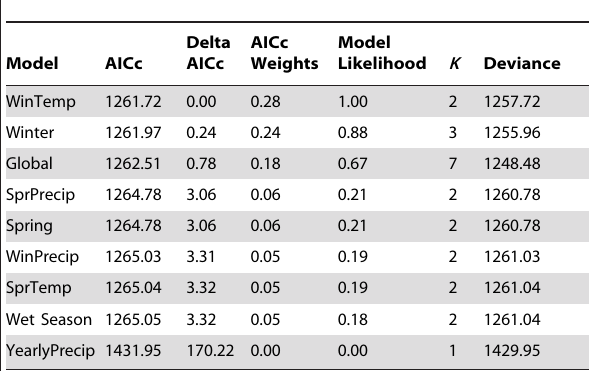
Table 5. Output from 9 a priori models used to estimate daily nest survival rates for 229 lesser prairie-chicken nests in Roosevelt County, NM, and Cochran, Hockley, Terry, and Yoakum counties, TX, USA,